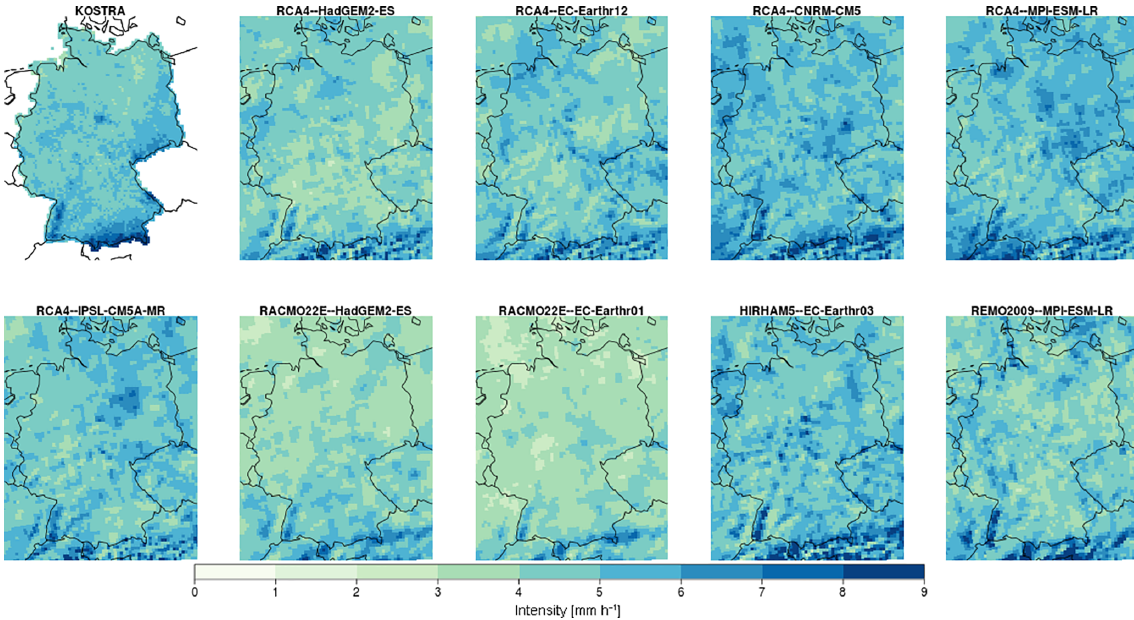
Figure 3. Intensity for 10-year return period for 12h duration of KOSTRA and all models in the RCM ensemble for Germany.